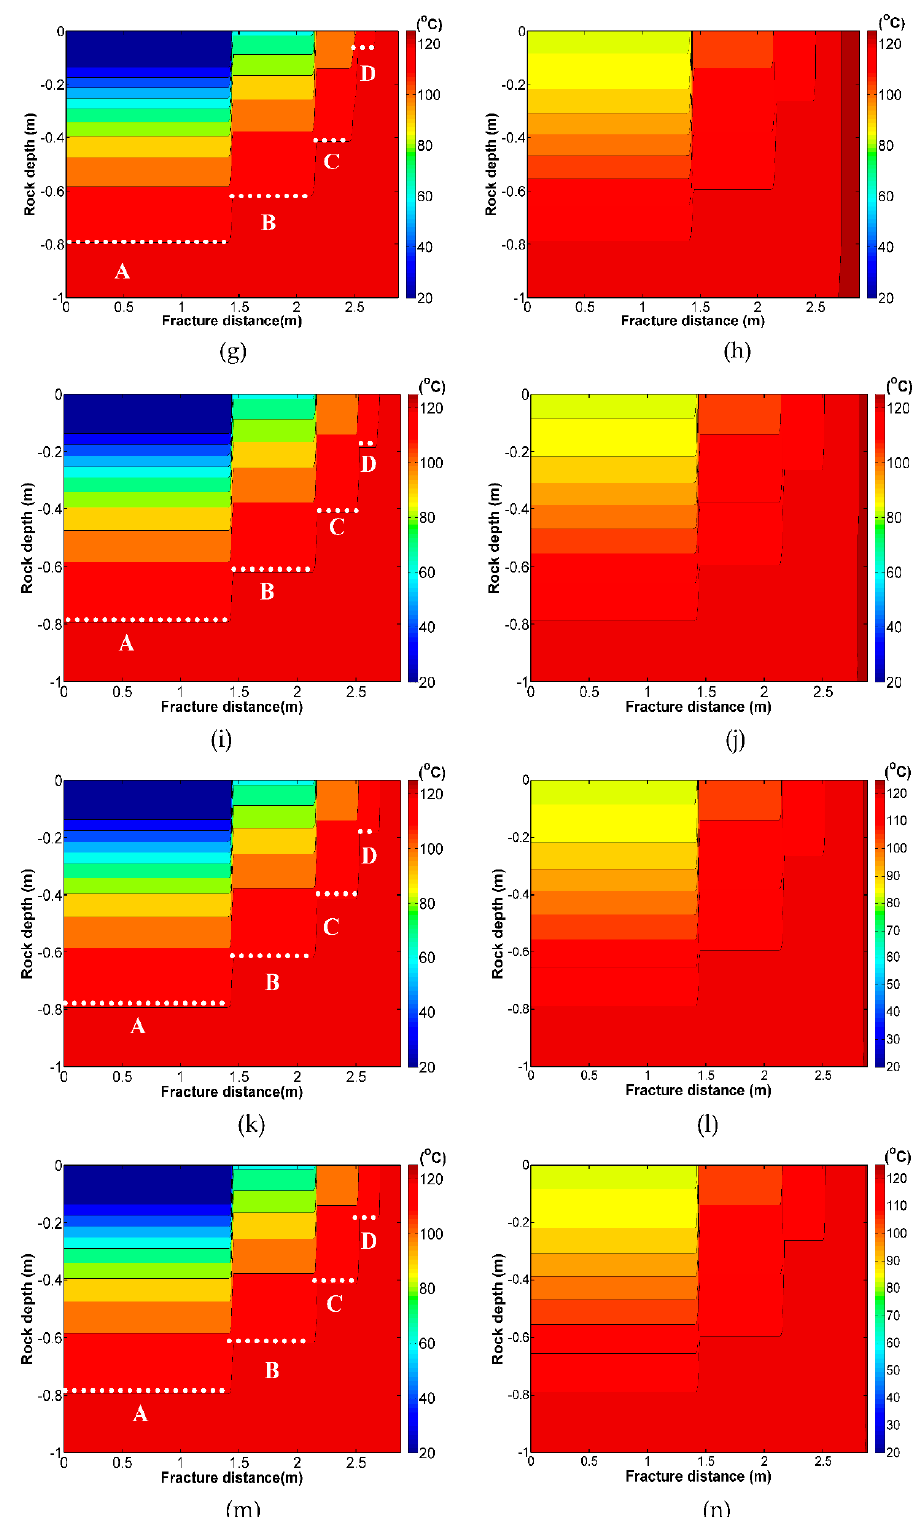
Figure 17. Illustration of the rock temperature evolution profiles after different days. Brine velocity v = 0.0001 m/s, initial brine temperature is 20 °C, and initial rock temperature is 125 °C. ( a ) Day 1, after 8 h brine circulation; ( b ) day 1, after 16 h flow stagnation/recovery; Same on–off circulation schedule for day 2 ( c , d ), day 3 ( e , f ), day 4 ( g , h ), day 5 ( i , j ) day 6 ( k , l ), day 7 ( m , n ).